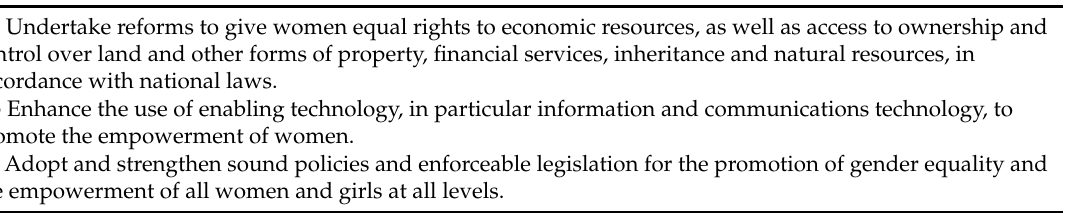
Table 1. Goal 5: Achieve gender equality and empower all women and